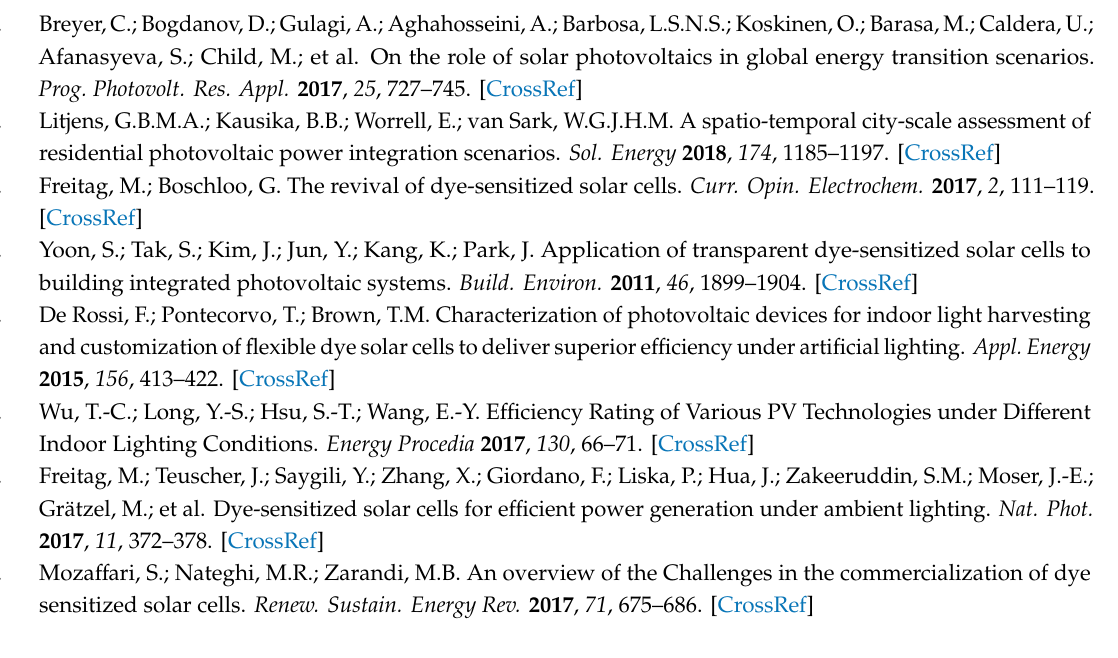
Figure S1: Device aging under 1 sun; Figure S2: DoE parameters; Figure S3: DoE coe ffi cient significance; Figure S4: Extracted charges; Figure S5: Carrier lifetime and transport